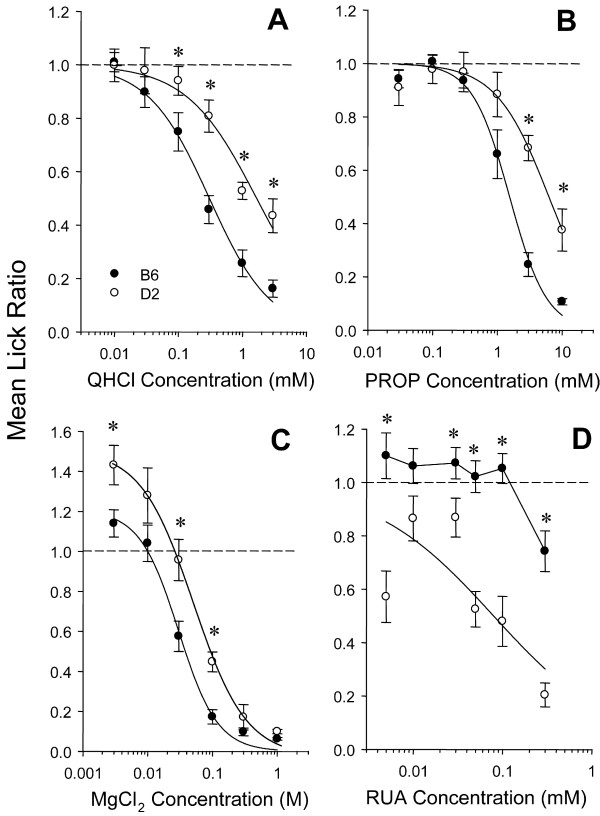
Lick ratios (mean ± SE) for B6 and D2 mice to concentration series of QHCl (A), PROP (B), MgCl2 (C), and RUA (D). The dotted lines on each graph represent a ratio score of 1.0, which indicates a lick rate equal to that of water. Asterisks identify significant strain effects at particular concentrations, as indicated by planned comparisons (p < 0.01). Lick ratios for each strain generally decreased with increasing concentration; B6 made fewer licks than D2 mice to high concentrations of QHCl (A) and PROP (B), and to both low and concentrations of MgCl2 (C). D2 mice made fewer licks than B6 mice at almost all concentrations of RUA (D).